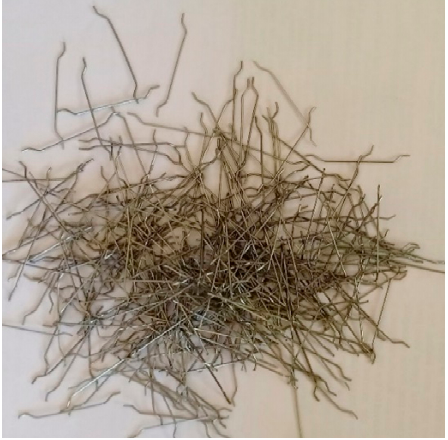
Figure 1. Hooked-end fiber.